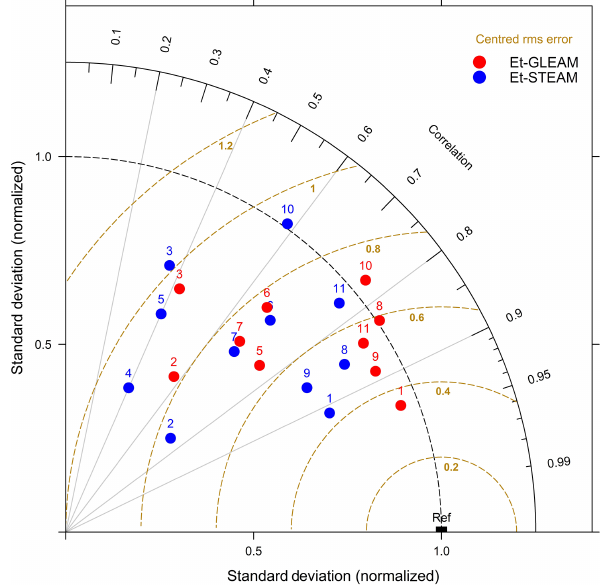
E p Figure 7. Density plot of E versus for comparison between P P models within the Budyko framework. The legend shows the fre- quency of